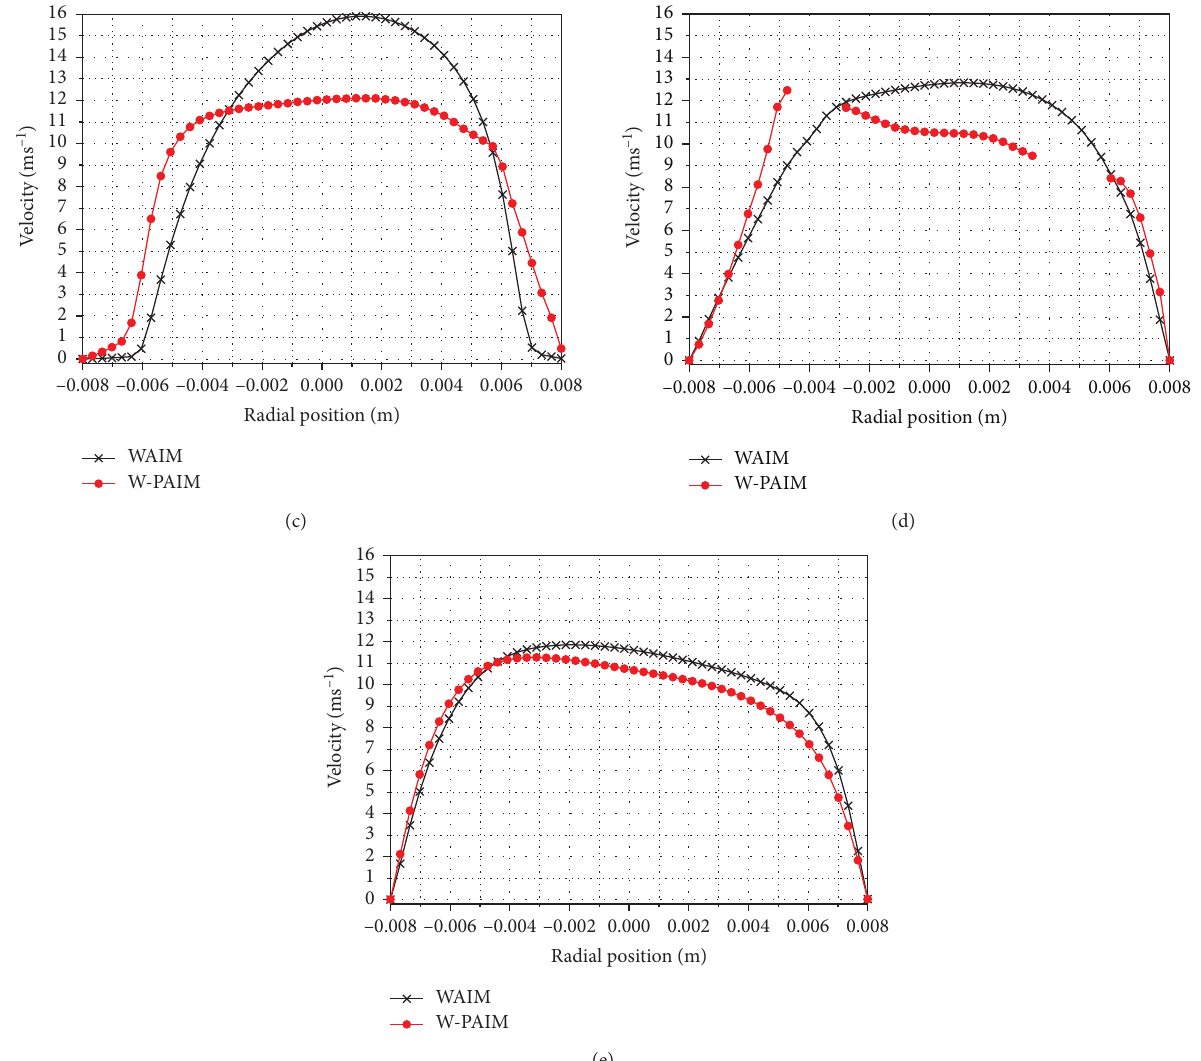
Figure 9: Comparison of the velocity distribution near the penetration front at the middle location of curved segments between WAIM and W-PAIM: (a) velocity magnitude contour of WAIM, (b) velocity magnitude contour of W-PAIM, (c) velocity profiles at position IV, (d) velocity profiles at position V, and (e) velocity profiles at position VI (IV, V, and VI denote the beginning, middle, and end of the curved segments, respectively. Negative radial positions are near the outer convex side of curved segments, while the positive radial positions are near the inner concave side).